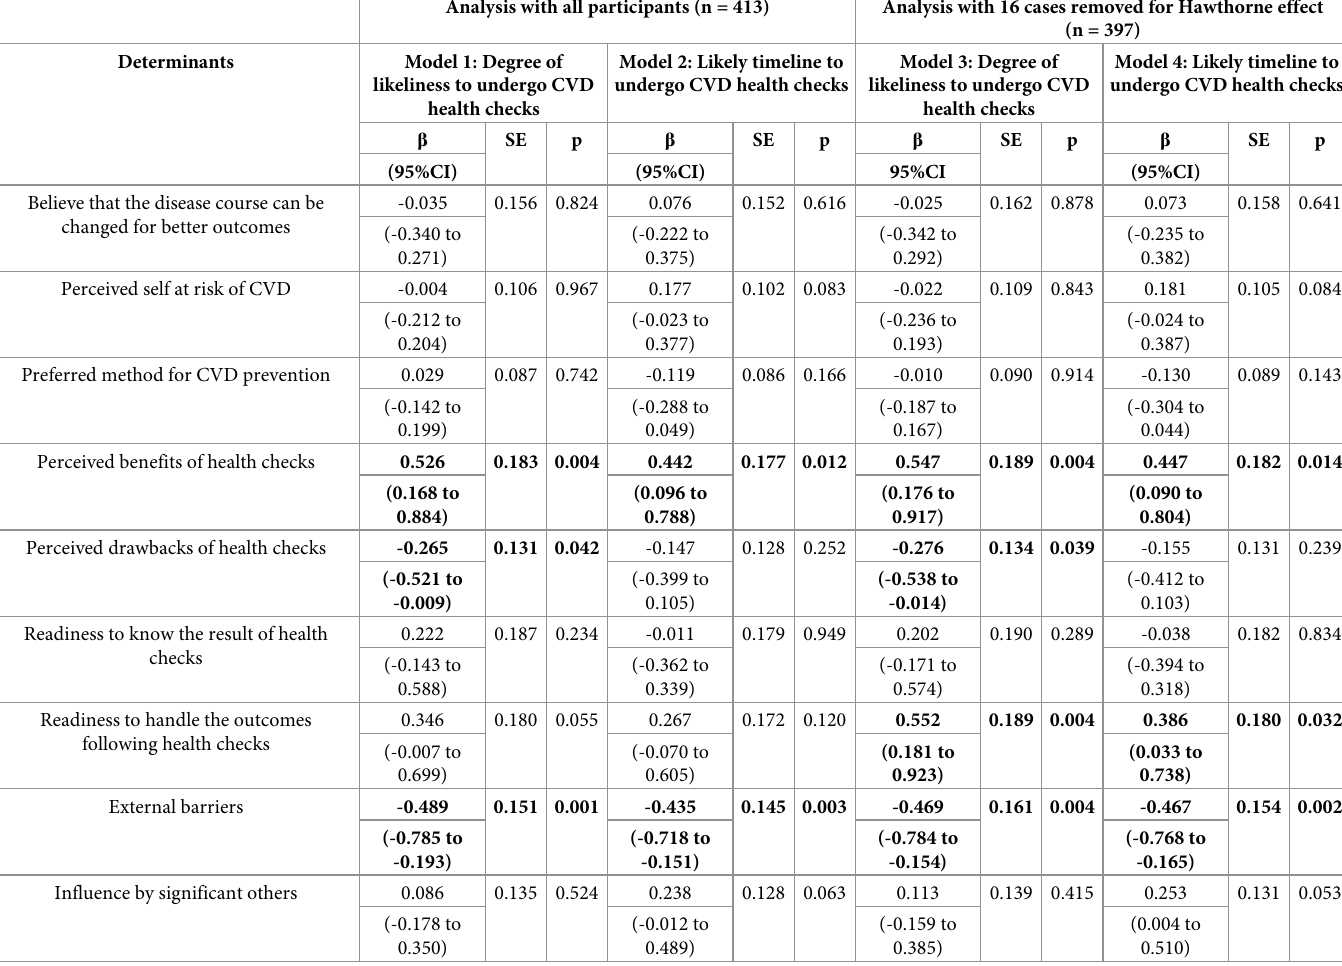
Table 3. Determinants of individuals’ intention to undergo health checks without adjusted for sociodemographic data. Analysis with all participants (n = 413) Analysis with 16 cases removed for Hawthorne effect (n =